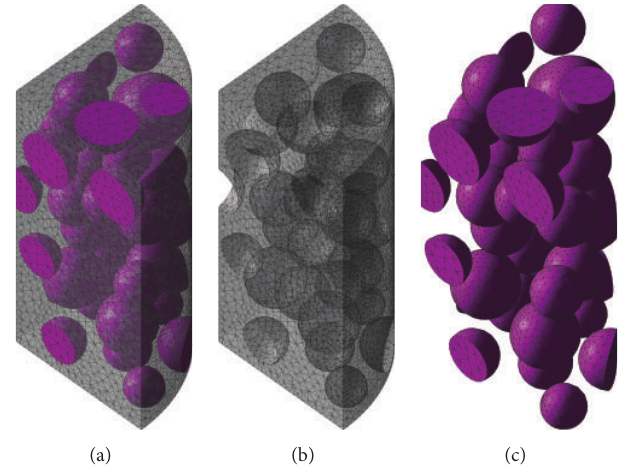
Figure 5: Numerical model: matrix and aggregates (a); matrix (b); aggregates